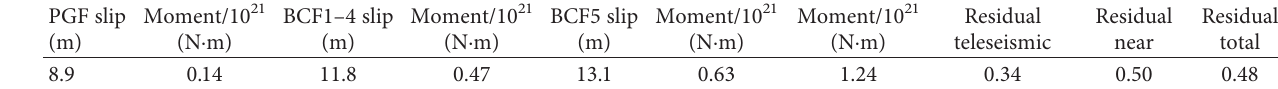
Table 2: The inversion